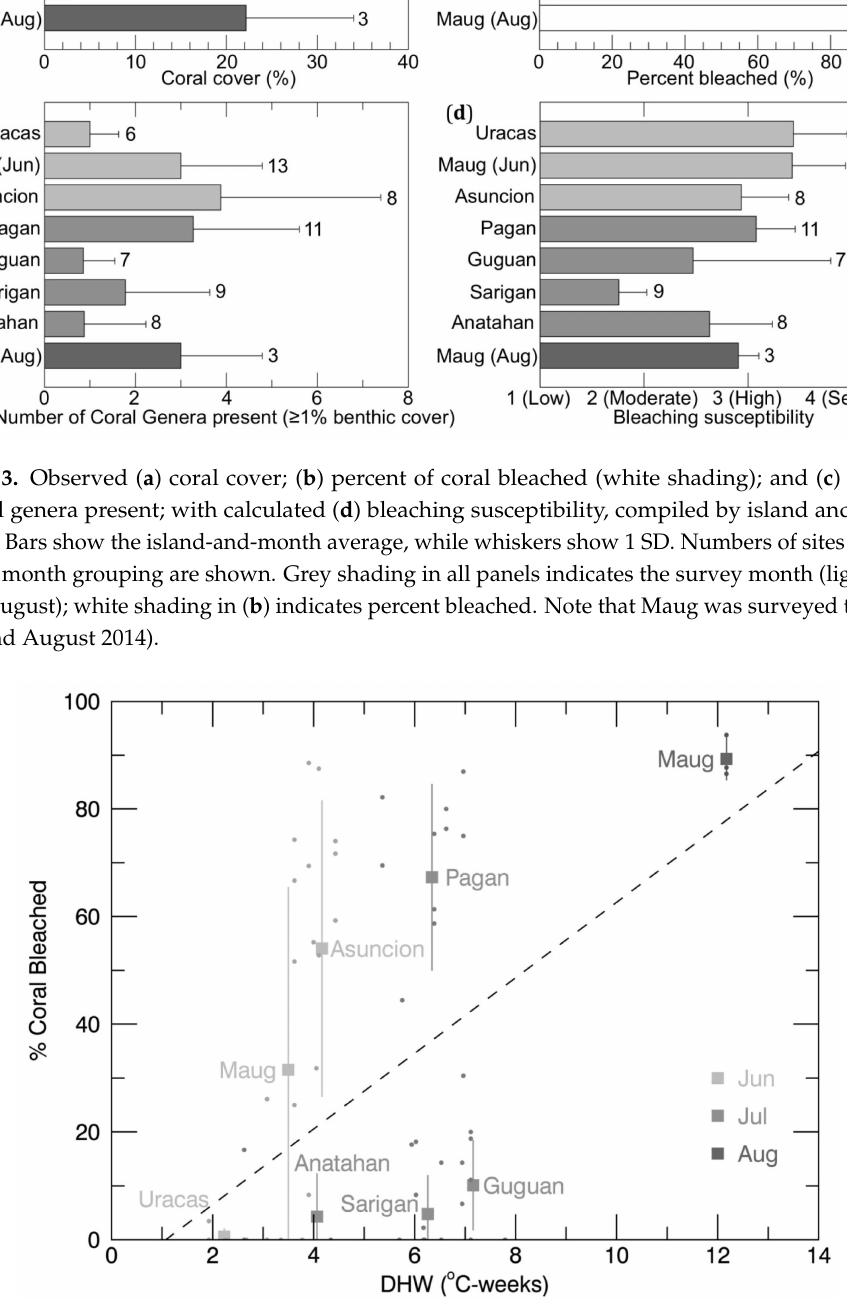
Figure 4. Comparison of percent coral bleached against Degree Heating Weeks (DHW). Site data (dots) were averaged by island and date (filled square), with the whiskers showing 1 SD. Symbol shading indicates the month of observation. The dashed line shows the linear regression of the island-scale data ( y = 7.0177 x (cid:1) 7.5183, r 2 =